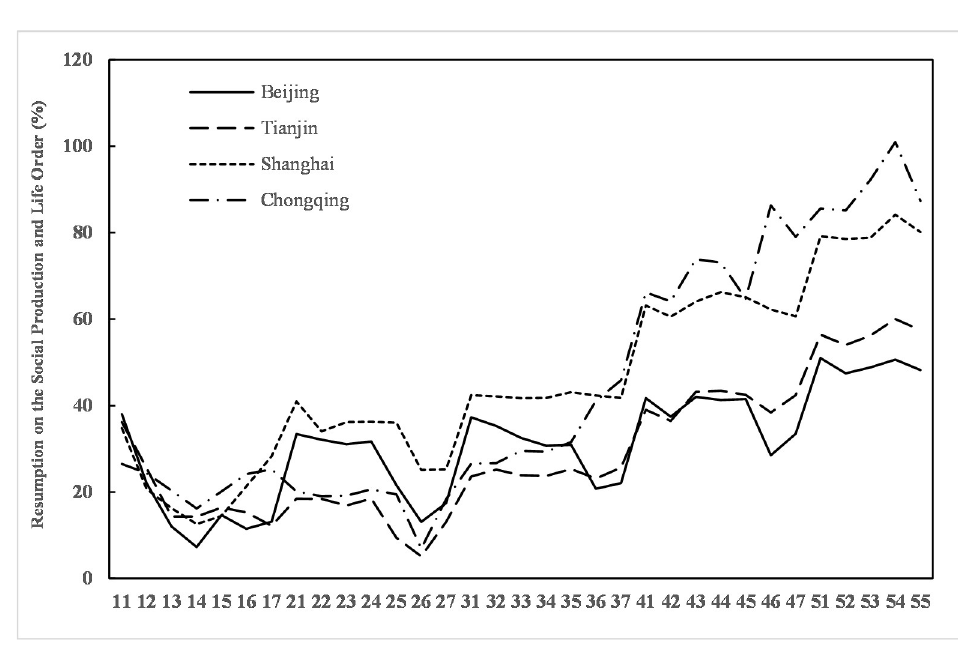
Fig 6. Changes in the resumption of social production and life in Beijing, Tianjin, Shanghai and Chongqing.